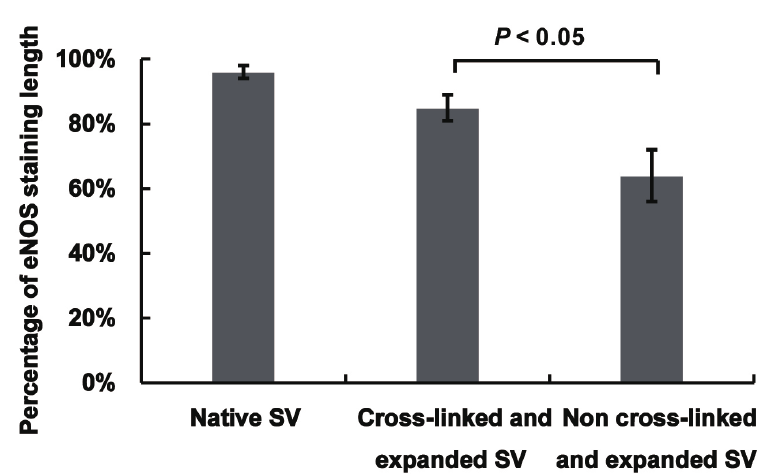
Fig. 5 - The quantitative comparison of endothelial nitric oxide synthase (eNOS) staining of human saphenous vein (SV). Adventitial cross-linking significantly preserved eNOS staining after high-pressure distension which indicated adventitial cross-linking protected the endothelial integrity under high-pressure